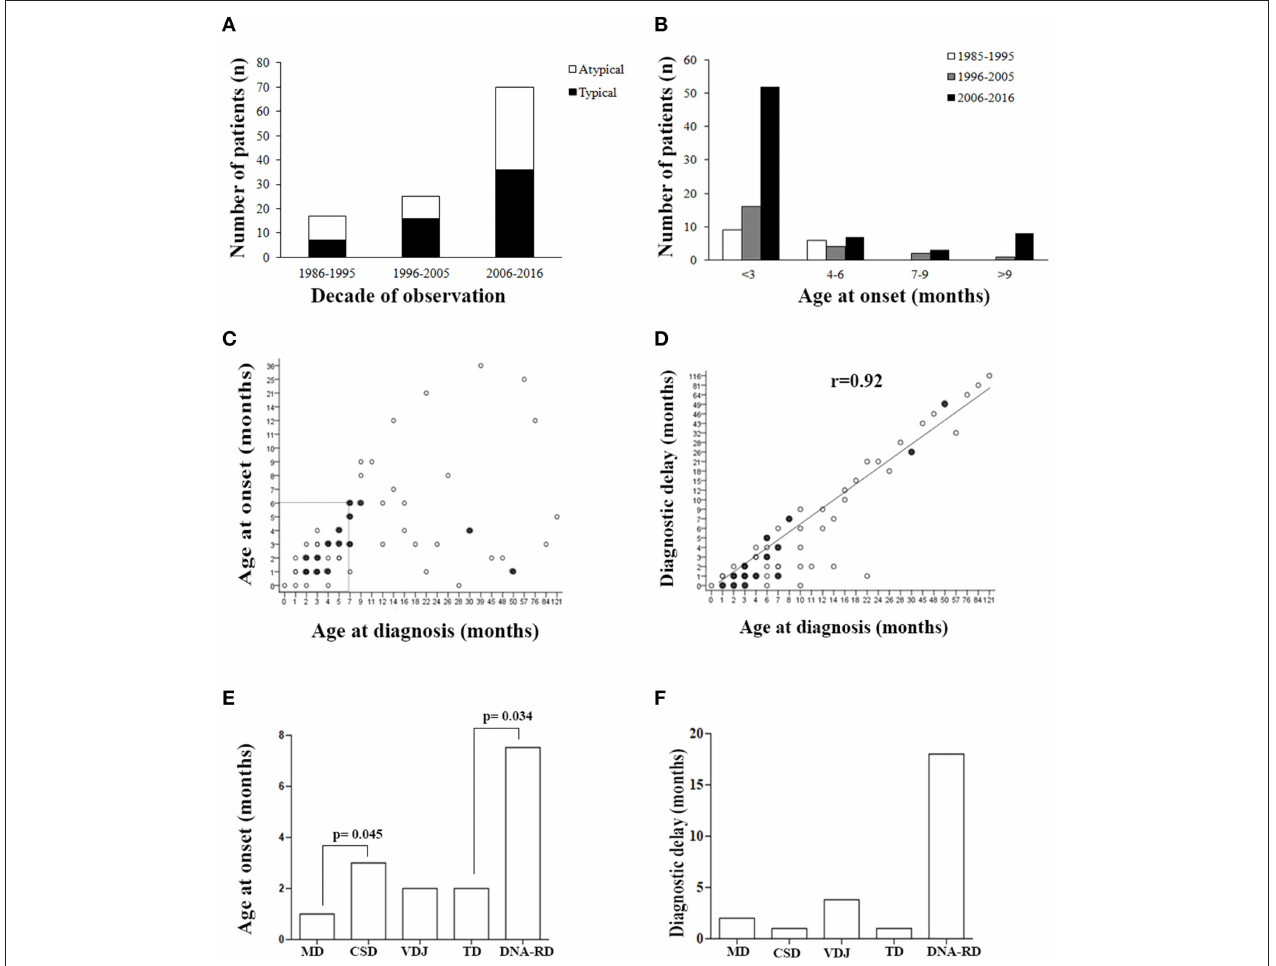
FIGURE 1 | Patients’ demographics. (A) Number of typical or atypical SCID patients diagnosed during the overall study period. (B) Histogram distribution of patients grouped by age at onset. (C) Correlation between age at onset and age at diagnosis, and (D) between age at diagnosis and diagnostic delay. Filled circles indicate groups of SCID patients (between 2 and 5) with same values. (E) Age at onset and (F) diagnostic delay (median) for the various pathogenic group of SCID. MD, Metabolic Disorders; CSD, Cytokine Signaling Disorders; VDJ, VDJ abnormalities; TD, Thymic Disorders; DNA-RD, DNA Repair